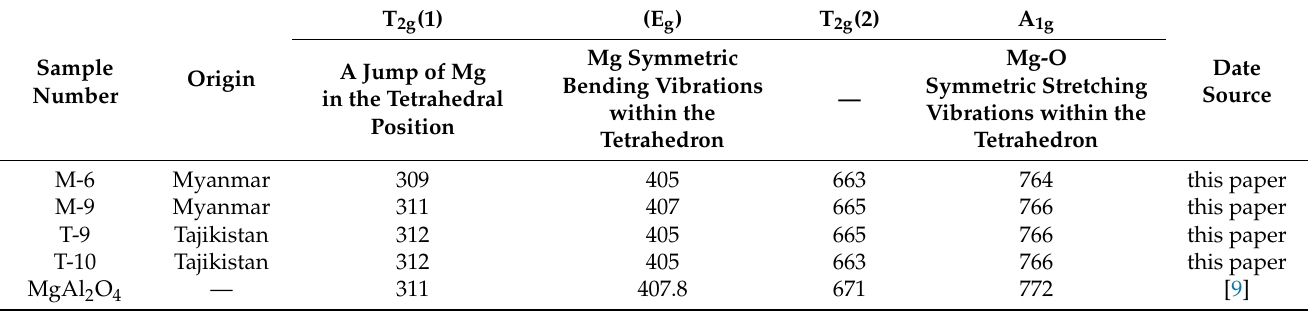
Table 1. Peak positions and attribution of the Myanmarese and Tajikistani spinels (cm − 1 ).